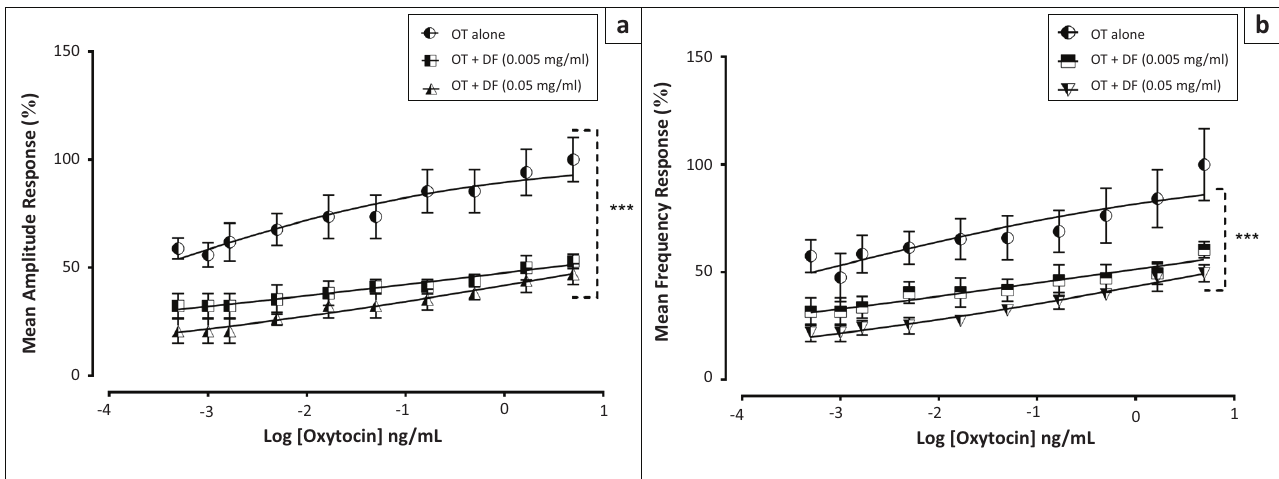
FIGURE 4: Concentration–response curves of oxytocin (0.0002 ng/mL–4.98 ng/mL) in the presence of D. filix-mas (DF). (a) Effect of DF (0.005 mg/mL and 0.05 mg/mL) on the amplitude of oxytocin-induced contractions. (b) Effect of DF (0.005 mg/mL and 0.05 mg/mL) on oxytocin-induced contractions. A concentration-dependent inhibition for both the amplitude and frequency was observed and a rightward shift in the concentration–response curves was observed. n = 5 animals.